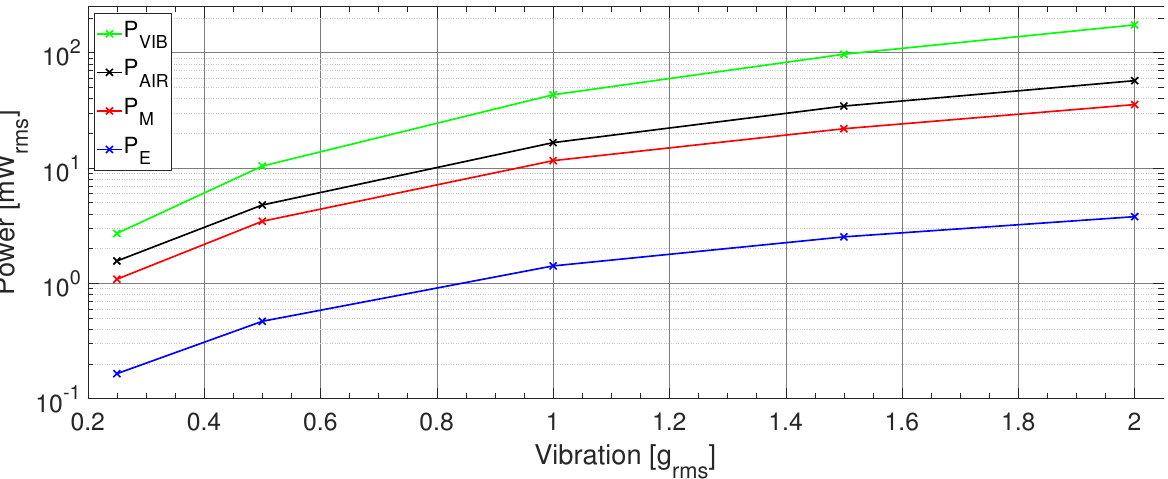
Figure 8. The PZT PEH: Comparing the power delivered by the shaker to the PEH, with the power dissipated in the air, the PEH mechanical vibration power, and the electrical power